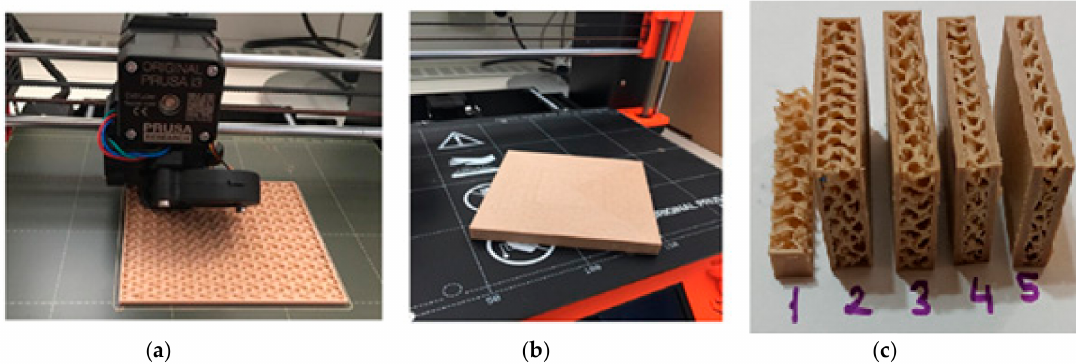
Figure 3. ( a ): The printing of the wood / PLA composite panel in the 3D printer; ( b ): The finished wood / PLA composite panel; ( c ): Cross-section of the specimens with di ff erent surface layer